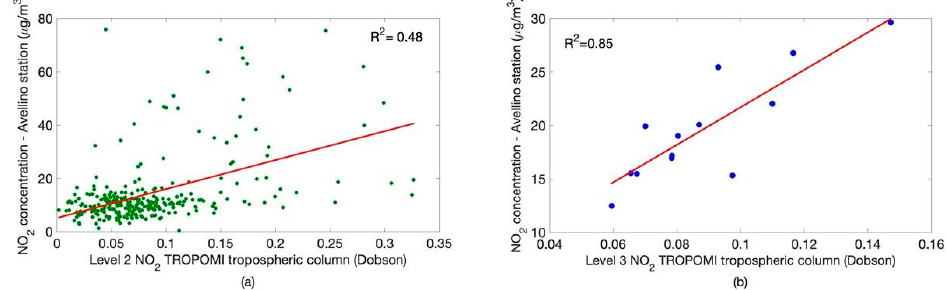
Figure 9. Scatter plot of NO 2 observations for the Avellino station. Before ( a ) and after ( b ) kriging. The analysis refers to the period of May 2018 – May 2019.